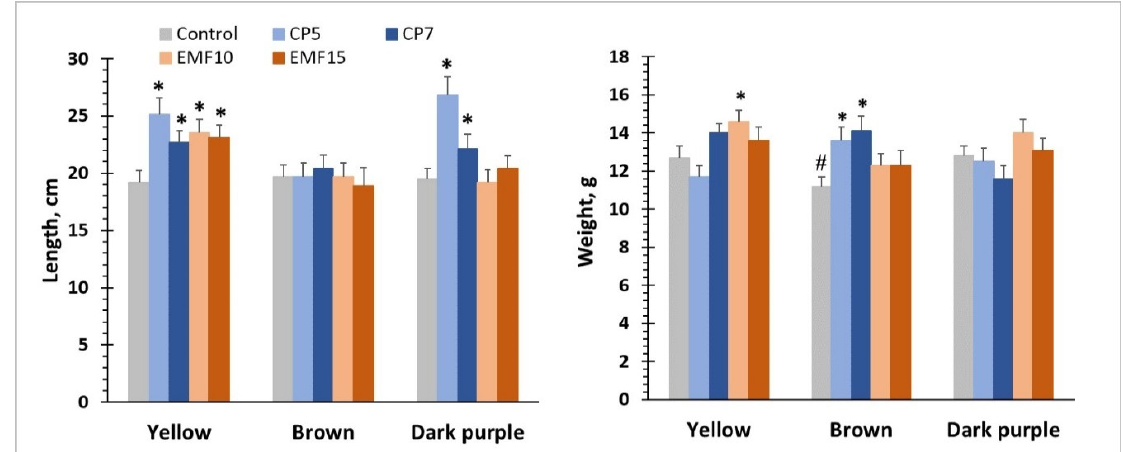
Figure 3. Morphometric parameters of red clover seedlings 7 days after sowing. The means ± standard errors are presented ( n = 24–29). * Significantly different from the control group ( p ≤ 0.05); # significantly different from seedlings growing from yellow seeds in the same treatment group ( p ≤ 0.05).